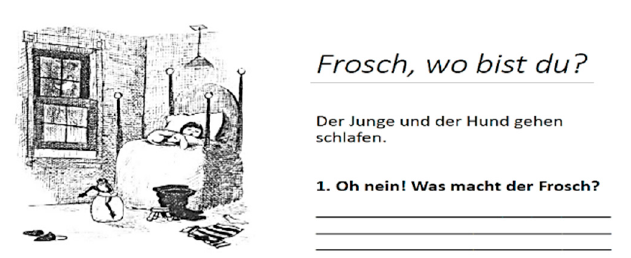
Figure 6. Example from the production pretest.